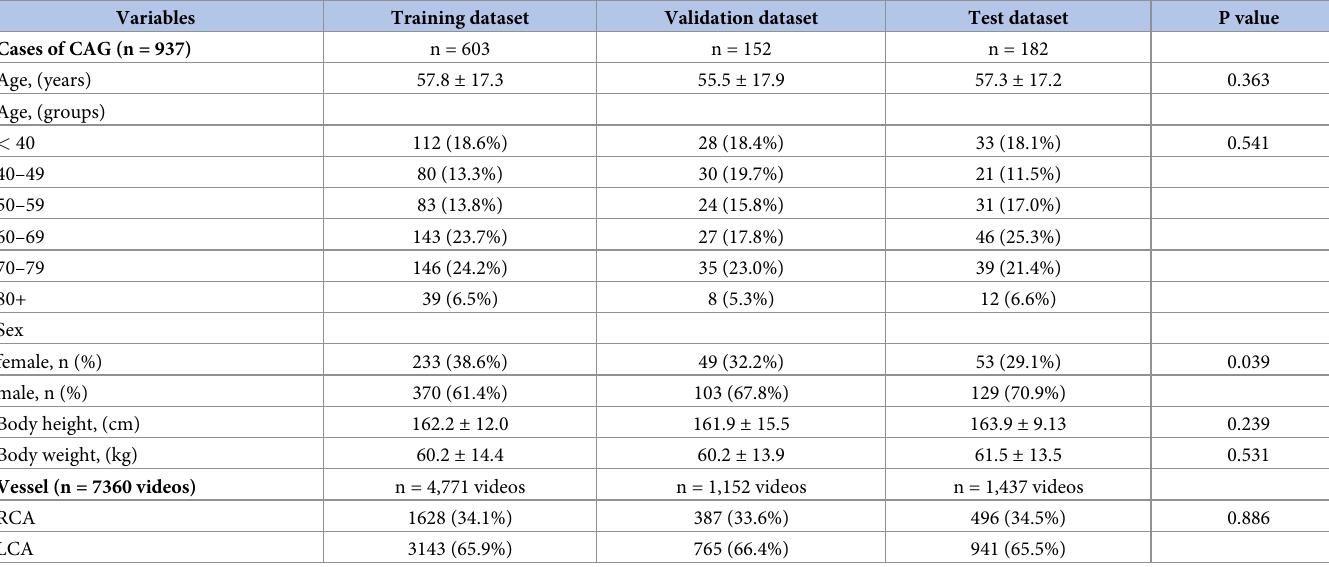
Table 1. Patient and vessel characteristics at the time of coronary artery